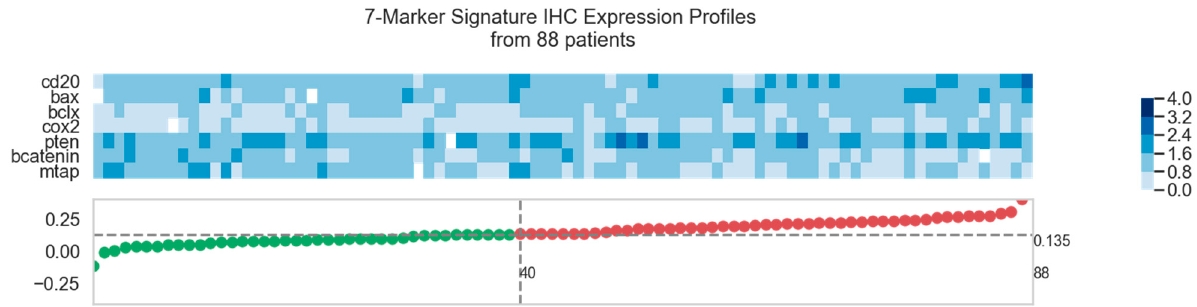
Figure 2. 7-marker signature immunohistochemistry (IHC) expression profile. The figure shows the IHC expression profile of all tumor specimens from the cohort ordered by their predicted risk score. Each column represents an individual patient consisting of the expression values of the 7-marker signature (5 risk markers and 2 protective markers). The corresponding risk score is plotted for the 40 low-risk patients (green) and the 48 high-risk patients (red). The horizontal line (at 0.135) corresponds to the signature’s cut-off value that separates the groups. The IHC expression values are scaled between 0 (light blue) and 3 (dark blue) according to the used stepwise scoring system (the expression value of 4—as originally described—did not occur in this particular cohort).